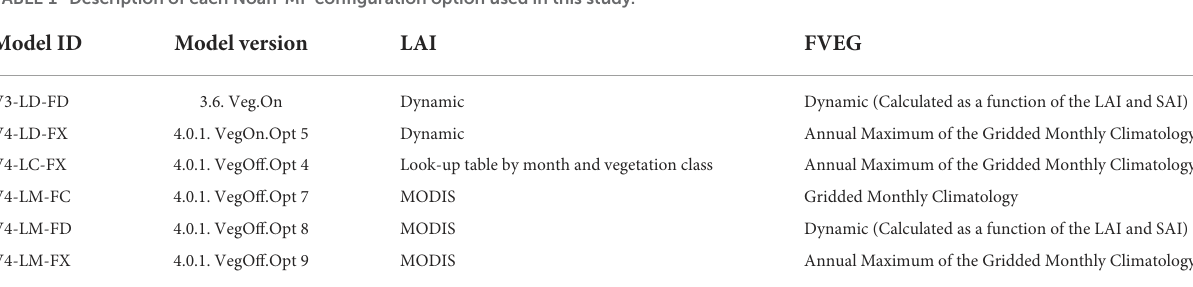
TABLE 1 Description of each Noah-MP configuration option used in this